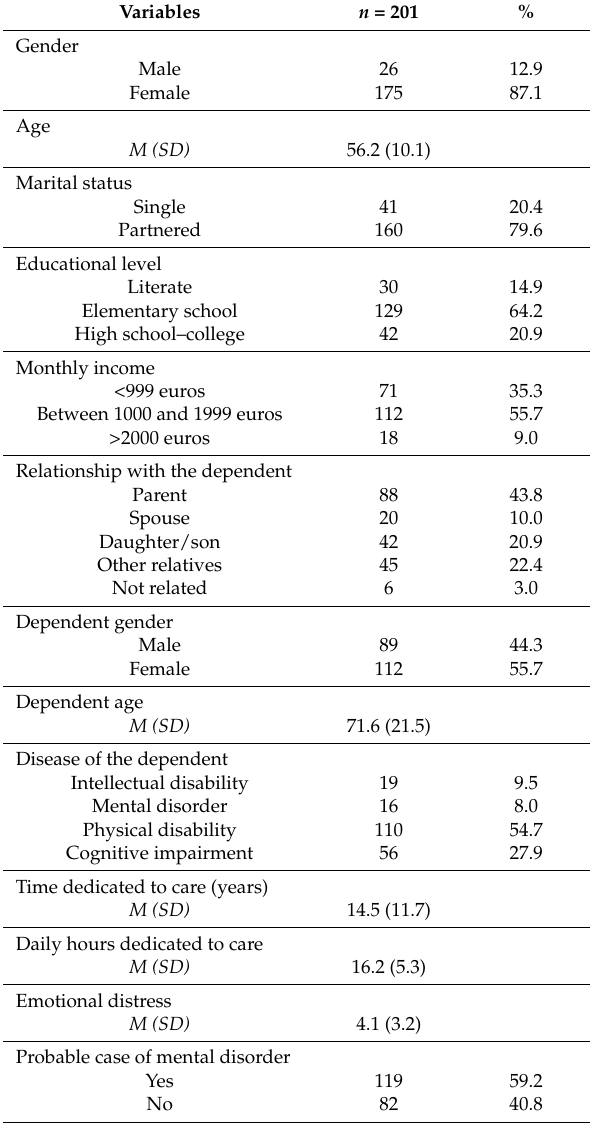
Table 1. Sociodemographic, care and clinical